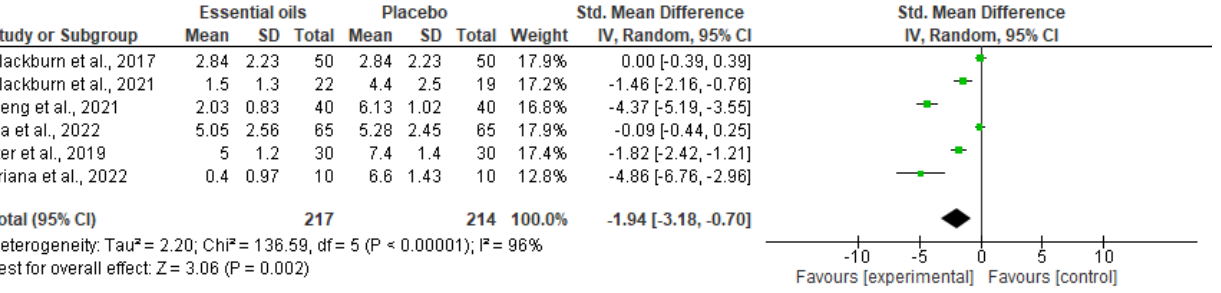
lication bias (Figure 4).